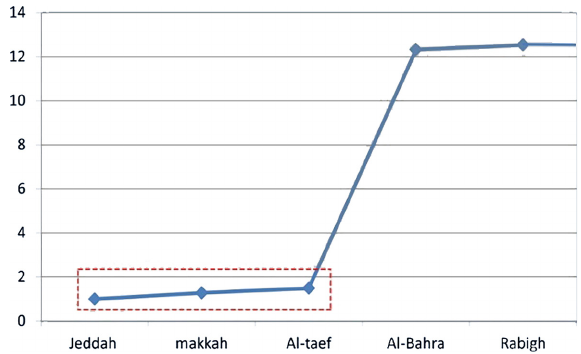
Fig. 6. Zoom shot of level 1 of the